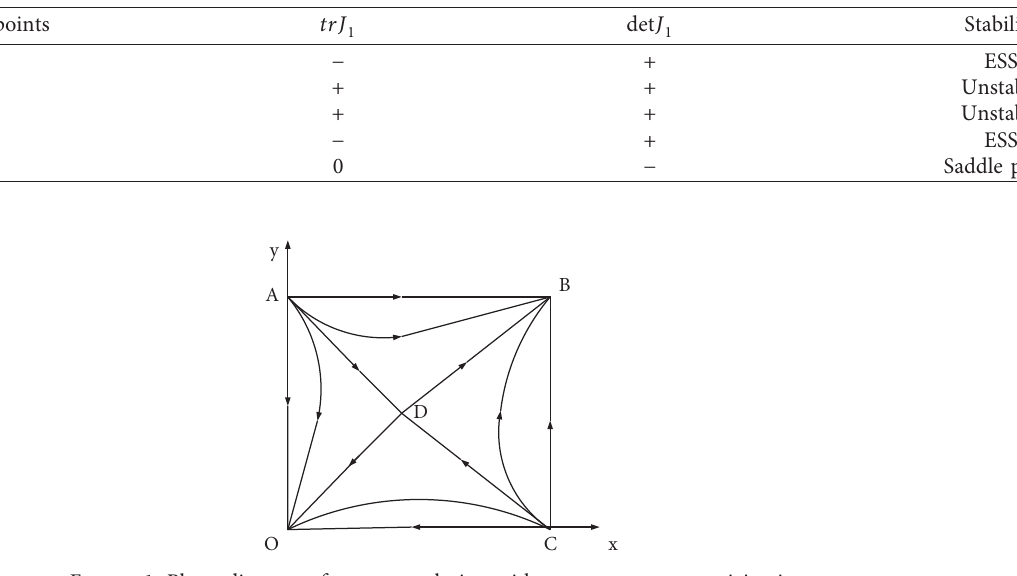
Table 2: Stability analysis of local equilibrium point of system without government participation.